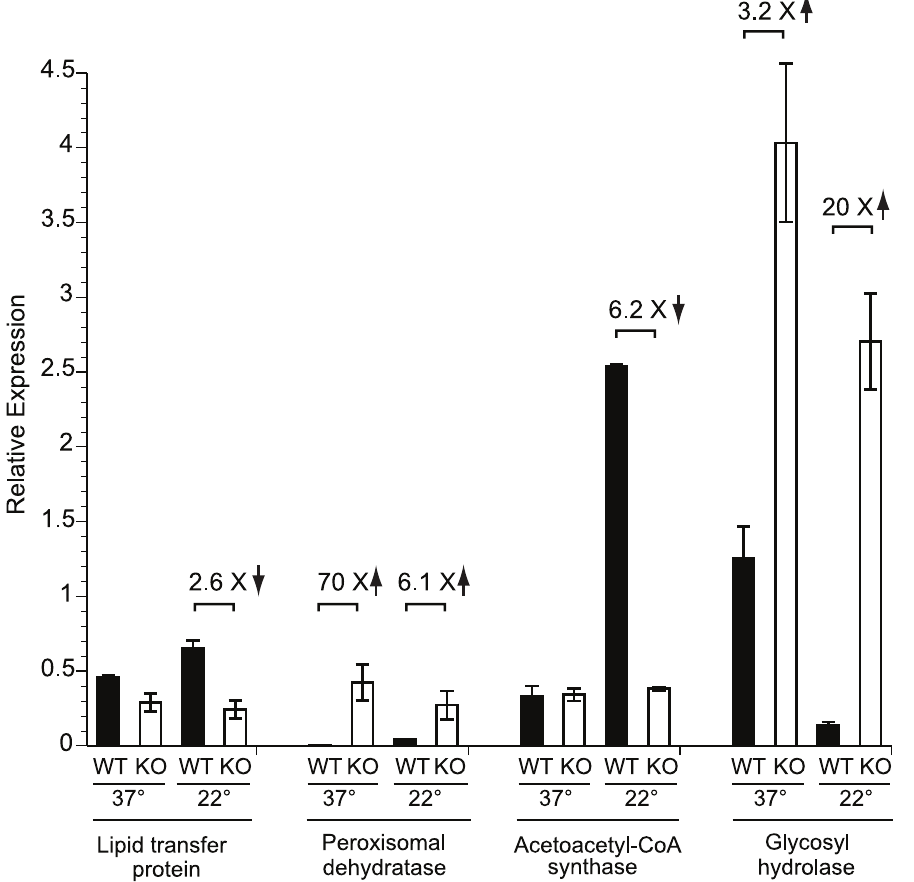
Figure 8. Expression of candidate genes in the SREB regulon at 37 u C and 22 u C. Quantitative RT-PCR (qRT-PCR) was performed to validate the expression of a subset of genes identified by bioinformatic and gene expression analyses. RNA was extracted from the wild-type (WT) strain and null mutant (KO) at 37 u C and at 22 u C (48 hours following the downward temperature shift). Deletion of SREB resulted in altered expression of genes involved with lipid metabolism and transport (lipid transfer protein, peroxisomal dehydratase, acetoacetyl-CoA synthase) as well as a glycosyl hydrolase that is predicted to have endo-1,3- b -glucanase activity. Data was generated from two biological replicates. qRT-PCR fluorescence was normalized to a